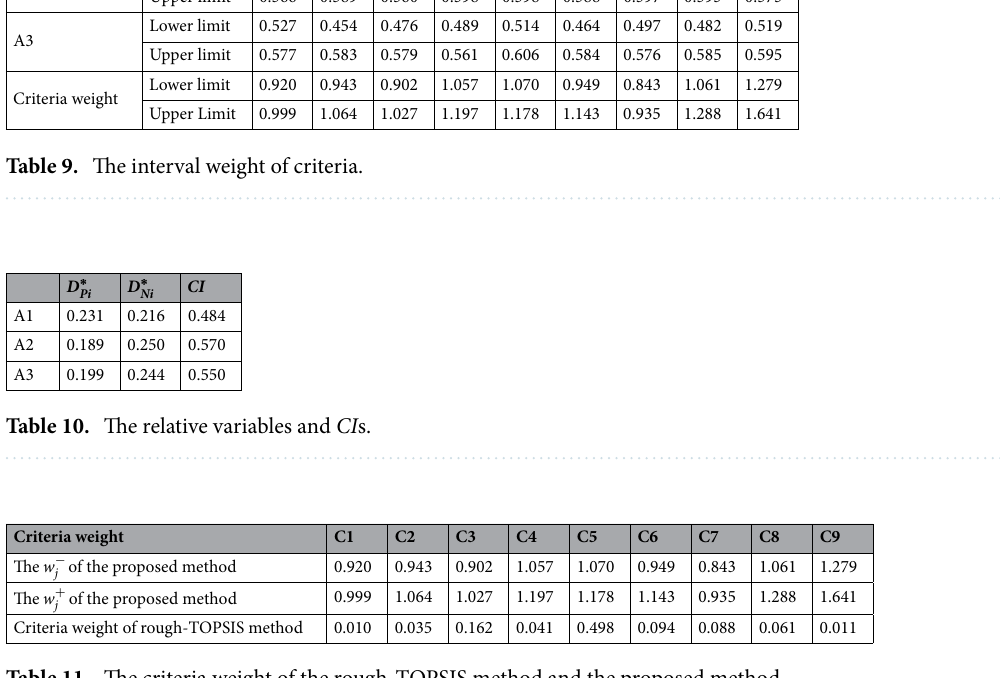
Table 11. The criteria weight of the rough-TOPSIS method and the proposed method.